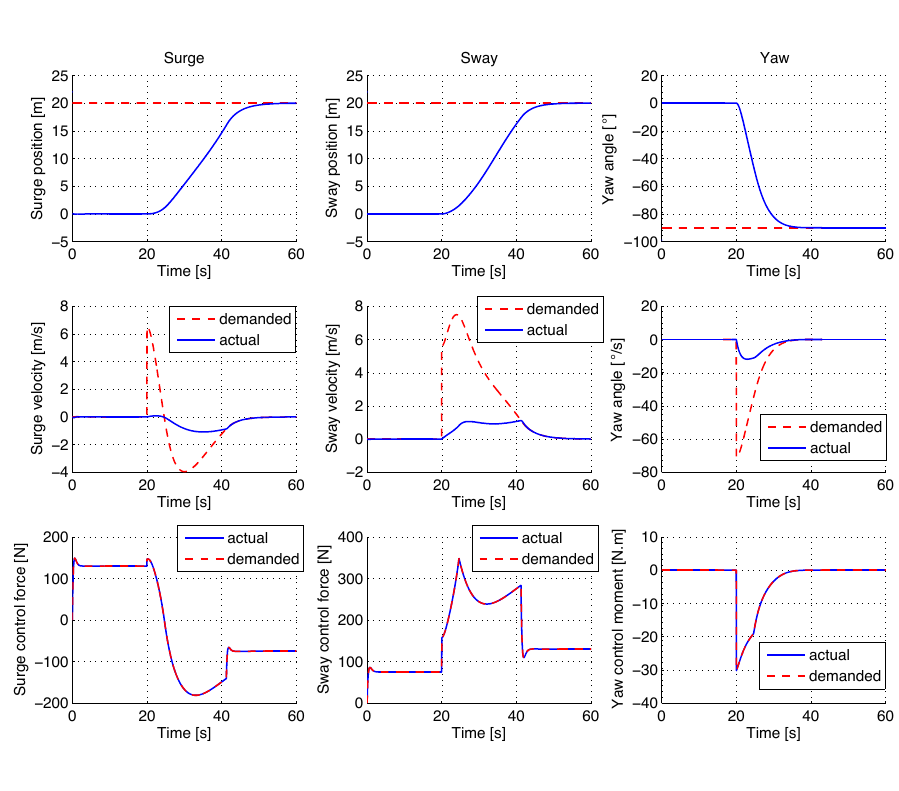
Figure 7: Performance of vehicle position regulation controller in current and position set point change.